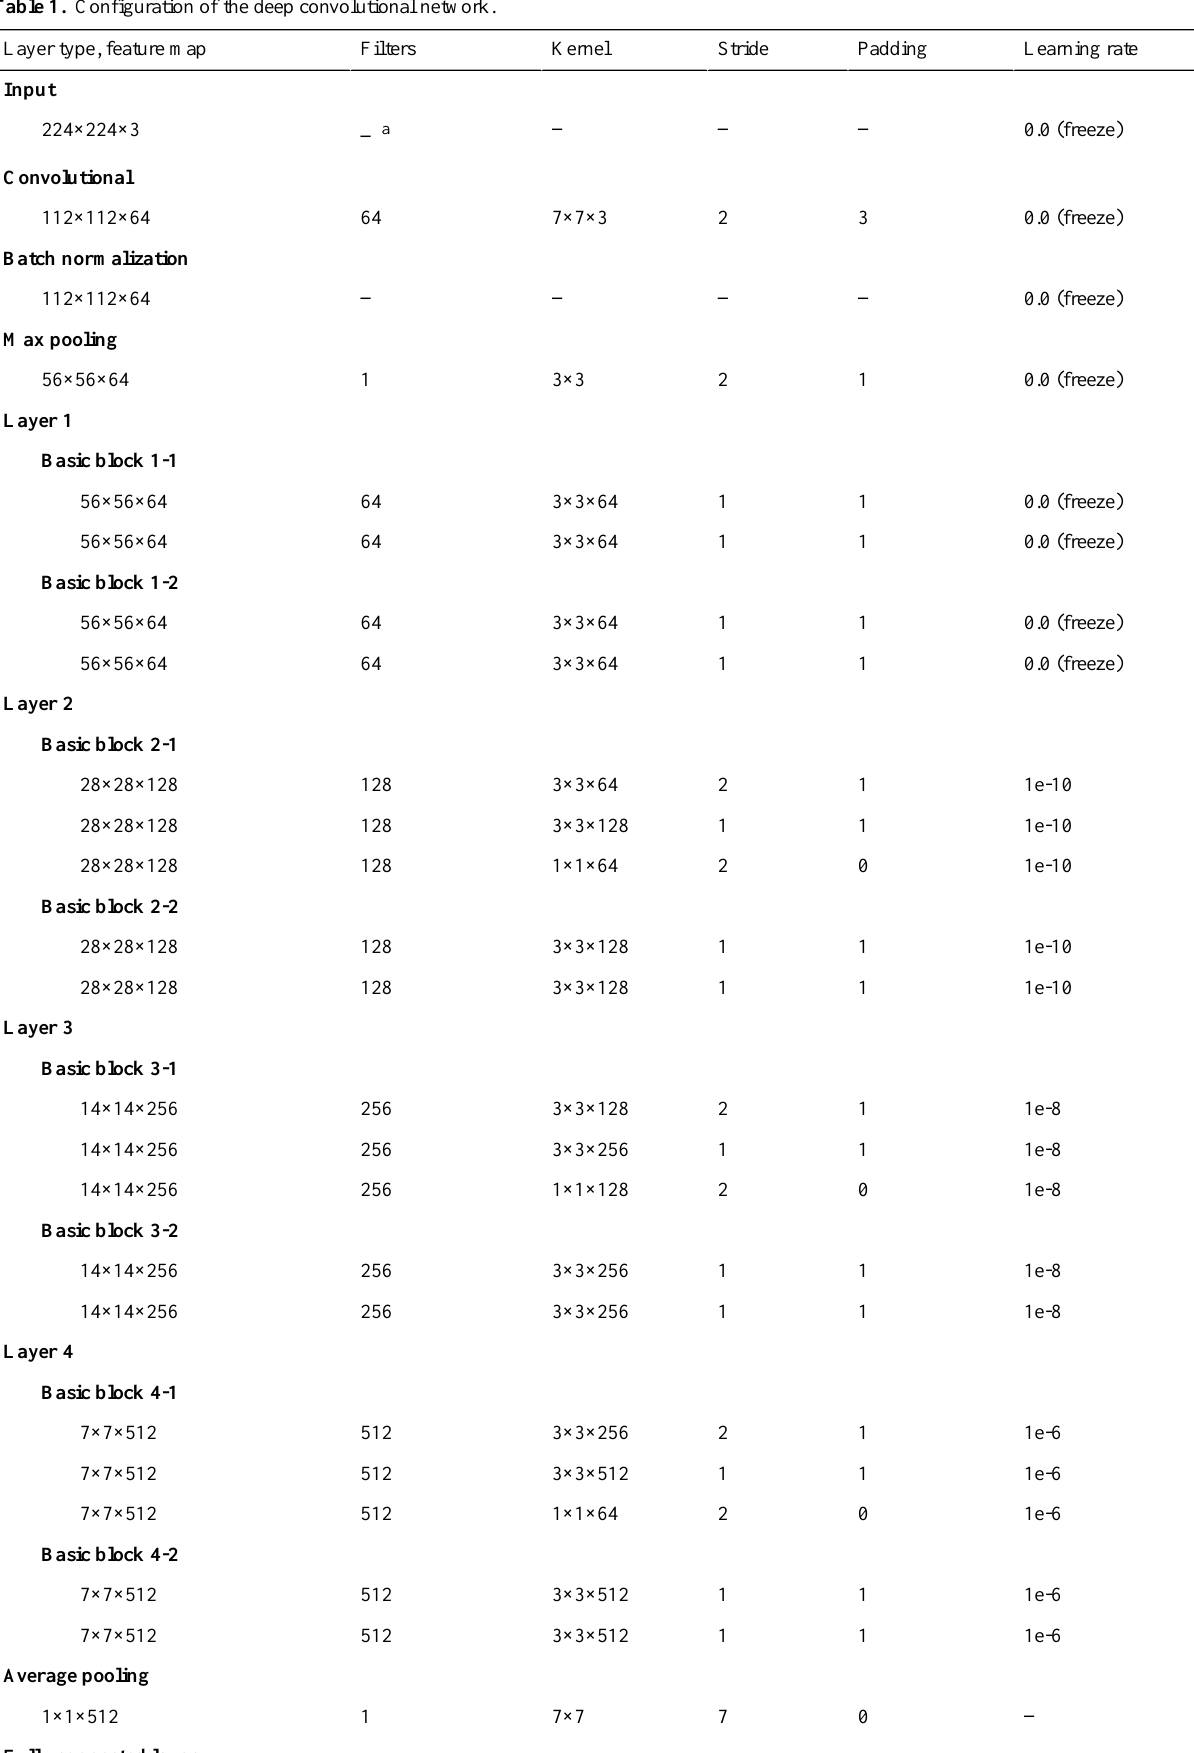
Table 1. Configuration of the deep convolutional